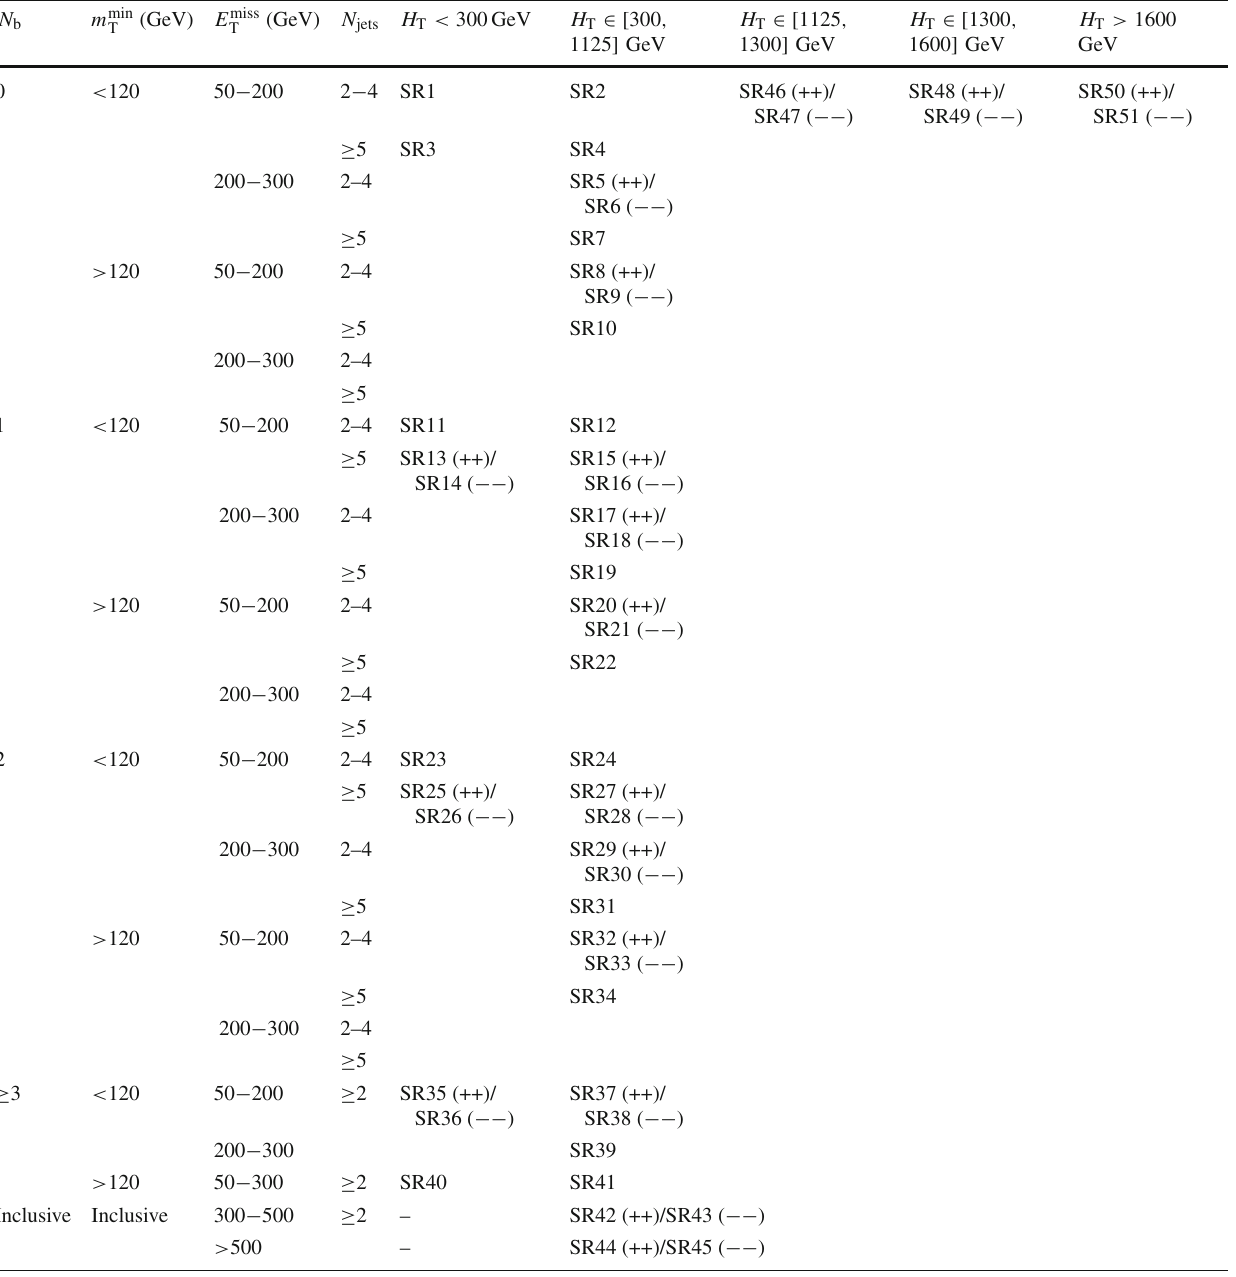
Table 2 Signal region definitions for the HH selection. Regions split by charge are indicated with (++) and ( −− ). All unlabeled region are included in the SR above them, for example the unlabeled regions